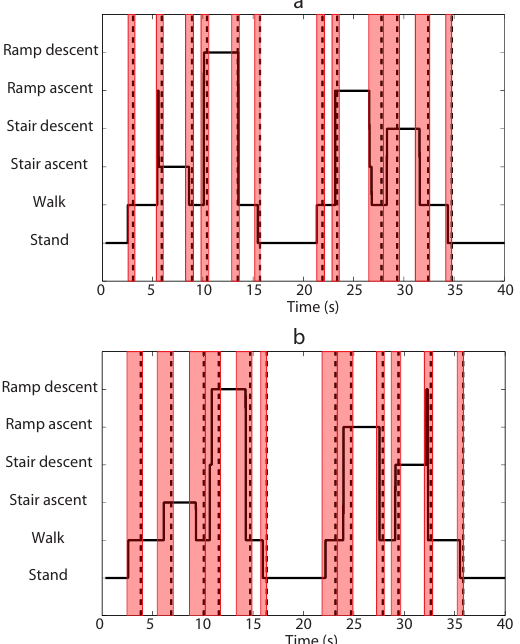
Figure 8. Recognition performances of online test experiments for Set-A experiment trial ( a ) and Set-B experiment trial ( b ). Data of 6 experiment pairs were used to train the system. The solid line denotes decision stream made by the locomotion intent recognition system. The dash line denotes the critical moment for each locomotion transition. Color shades denote locomotion transition periods of each